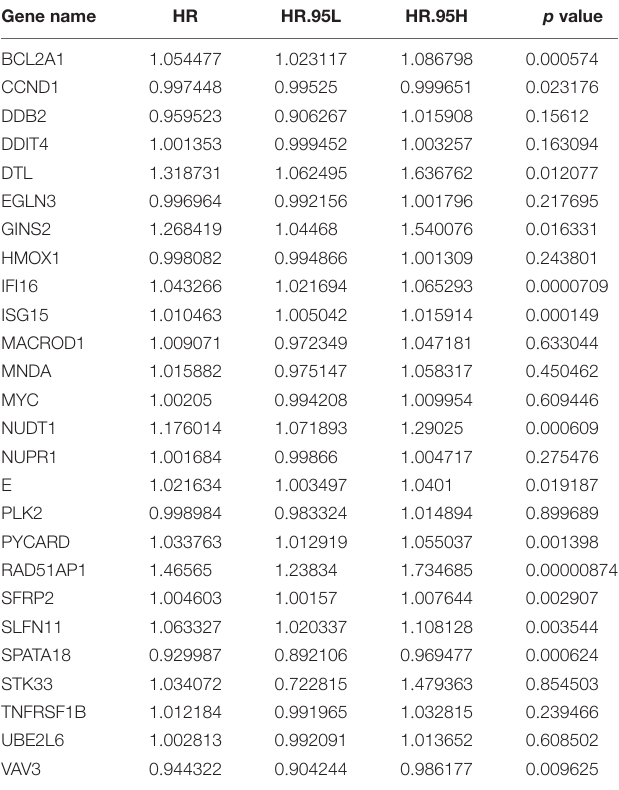
TABLE 2 | Univariate analysis of 26 DNA damage repair genes in patients with